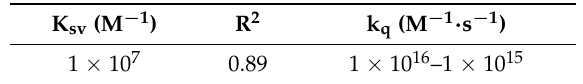
Table 2. Parameters obtained from fluorescence quenching data fitted with Stern ‐ Volmer equation [23]. Only the initial points of the titration in which the fluorescence decreases increasing the titrant concentration were used for the Stern ‐ Volmer fitting.